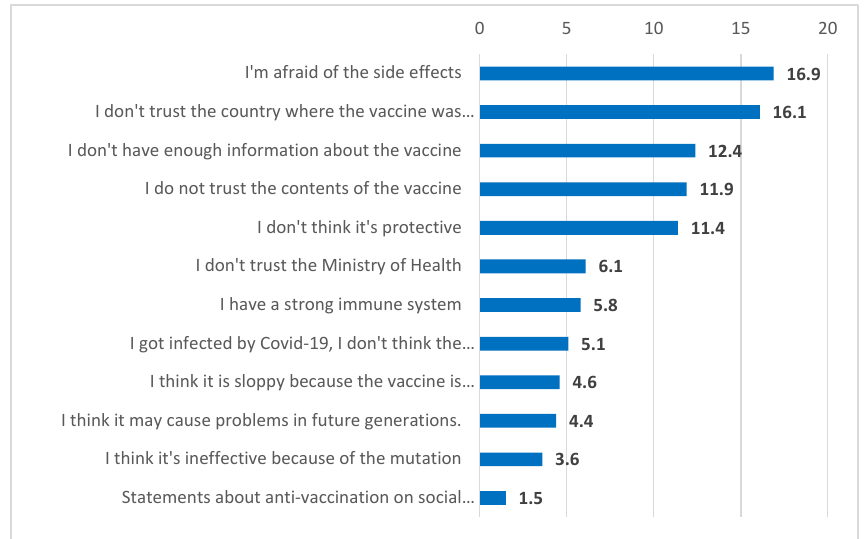
Table 2. The relationship between being infected with COVID-19, anxiety experienced during the pandemic, ability to cope with thoughts about COVID- 19, effect of the pandemics on young people’s expectations for their futures, accessing healthcare services, receiving accurate and sufficient infor- mation on proposed vaccines, information from the MoH and the scientific committee and being vaccinated.